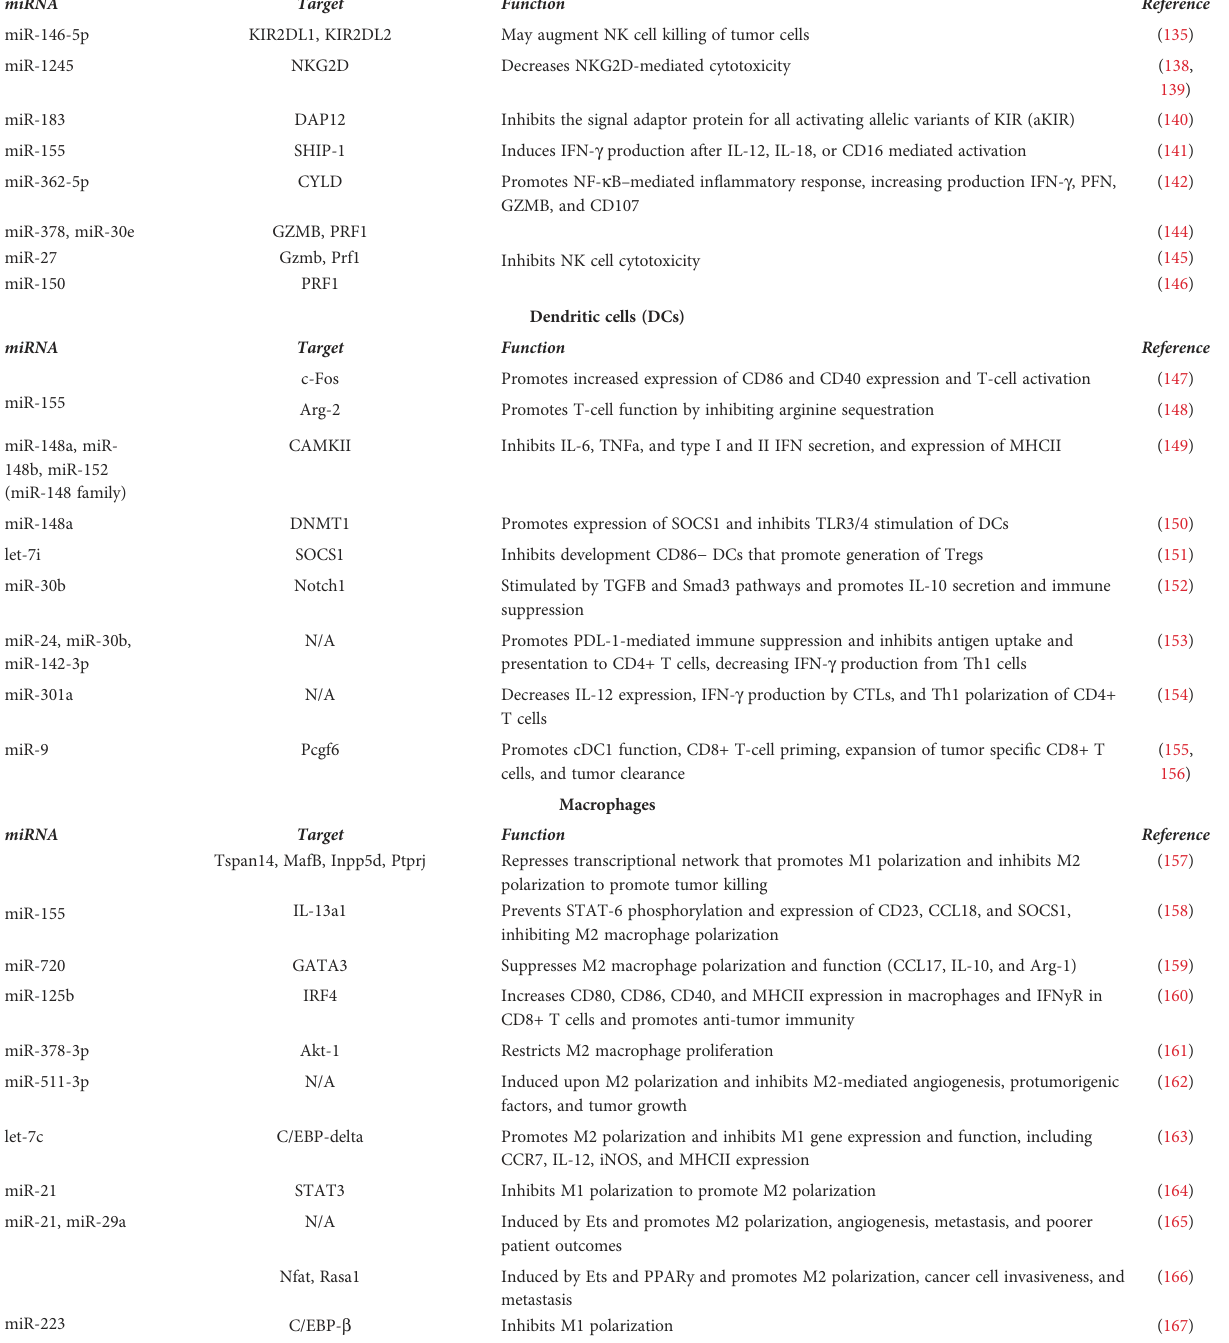
TABLE 2 NK cell, DC, macrophage, and MDSC miRNAs, targets, and